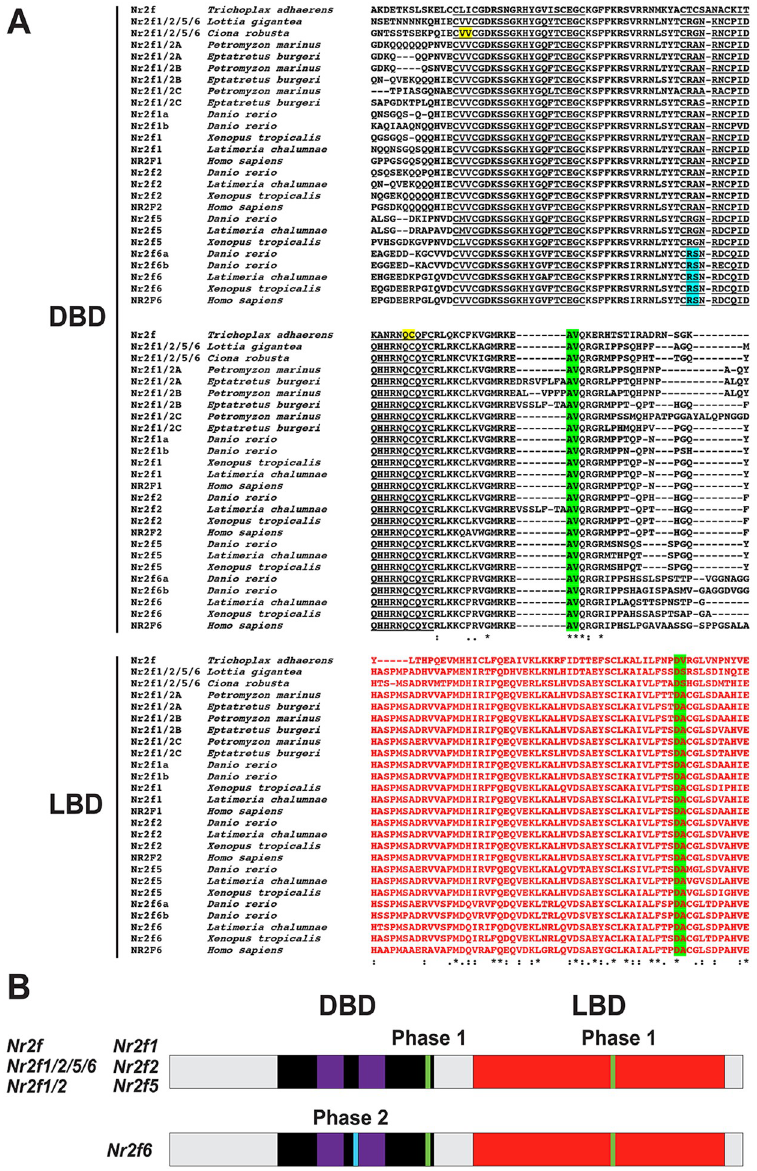
Fig 4. Intron code of the Nr2f family in metazoans. (A) Protein alignment showing conservation of intron/exon structures within the DBDs (black) and LBDs (red) of Nr2f members. Znfs in the DBDs are underlined. Phase 0 introns—yellow, phase 1 introns—green, and phase 2 introns—turquoise. Asterisks indicate 100% amino acid conservation. Colons indicate high levels ( > 90%) amino acid conservation. Periods indicate moderate levels (50–89%) of amino acid conservation. (B) Schematization of intron/exon boundaries of Nr2f genes as they relate the Nr2f protein DBD and LBDs. Black box indicates DBD. Purple boxes represent the zinc-fingers motifs within the DBD. Red boxes indicate the LDB. Colored bars indicate the conserved Nr2f Phase 1 introns (green) and the Nr2f6 -specific Phase 2 intron (turquoise). ( S . kowalevskii) [54] (S2 Fig). However, the limited synteny still corroborates the existence of the invertebrate Nr2f1/2/5/6 cluster shown in the phylogenetic trees (Fig 2; S1 Fig). Further- more, the only remaining synteny between Nr2f1/2/5/6 in invertebrates and vertebrate ortho- logs appears to be the linkage between UNC45A and NR2F2 of primates and Unc45a and